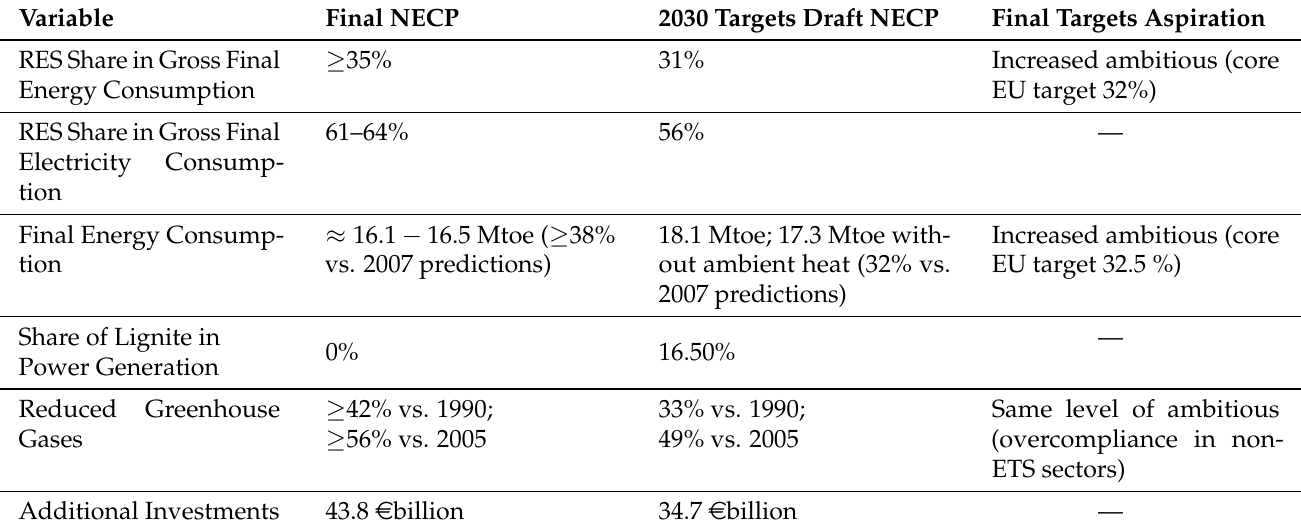
Table 1. Main quantitative targets set for 2030 under the final and draft versions of the Greek National Energy and Climate Plan (NECP). The aspiration level of the final NECP targets is evaluated against the core European ones to facilitate comparisons [16].